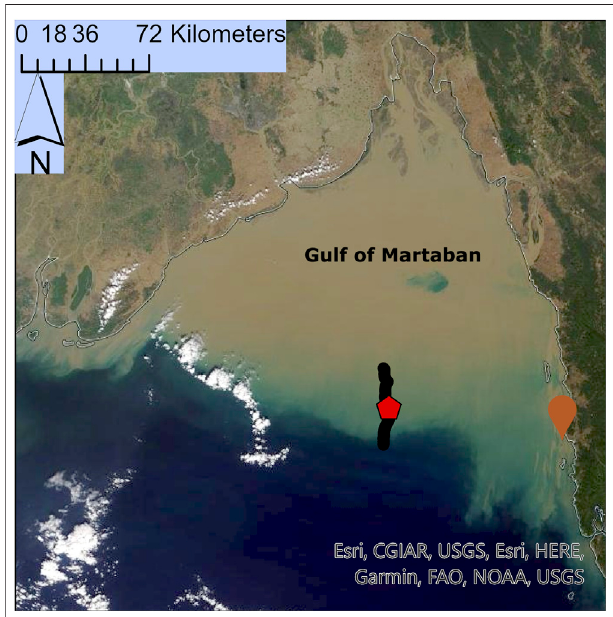
FIGURE 6 | Satellite image taken on the same day that Transect #21 was sampled. Location of transect (black line) and CTD-tu (red mark) shown. Duya, Myanmar shown as orange mark. Image from NASA